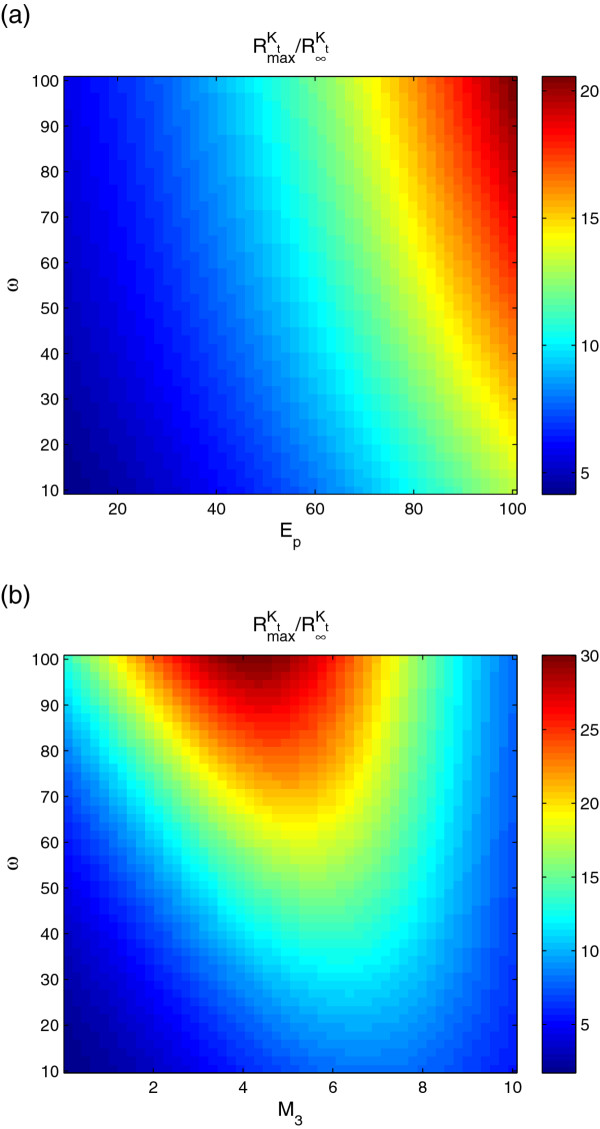
Robustness of the bell-shaped response. To illustrate the robustness of the bell-shaped response, the ratio of RmaxKt, the maximum of R with respect to Kt, to R∞Kt is calculated as multiple parameters are varied. The red regions correspond to parameter values with the largest bell-shaped response. (a) ω and Pt are varied (κ−1as a variable in ω). (b) ω and M3 are varied (κ−1 as a variable in ωand λ3 as a variable in M3). Parameter values used in the extended model with only phosphatase active in (a) and (b): λ−1 = 10 s−1,λ1 = 1μM−1s−1,k1 = 1 s−1,λ−2 = 10 s−1,λ2 = 20μM−1s−1,k2 = 1 s−1,λ−3 = 10 s−1,λ3 = 1μM−1s−1,k3 = 100 s−1,κ−1 = 10 s−1,κ1 = 1μM−1s−1,Pt = 1μM,St = 10μM.